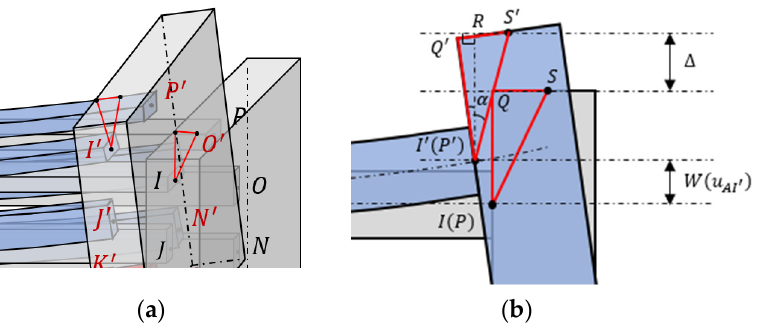
Figure 6. The geometric relationship between w ( u AI (cid:48) ) and output displacement of the 3D U-shaped actuator ∆ . ( a ) Stereoscopic view; ( b ) the flat view.